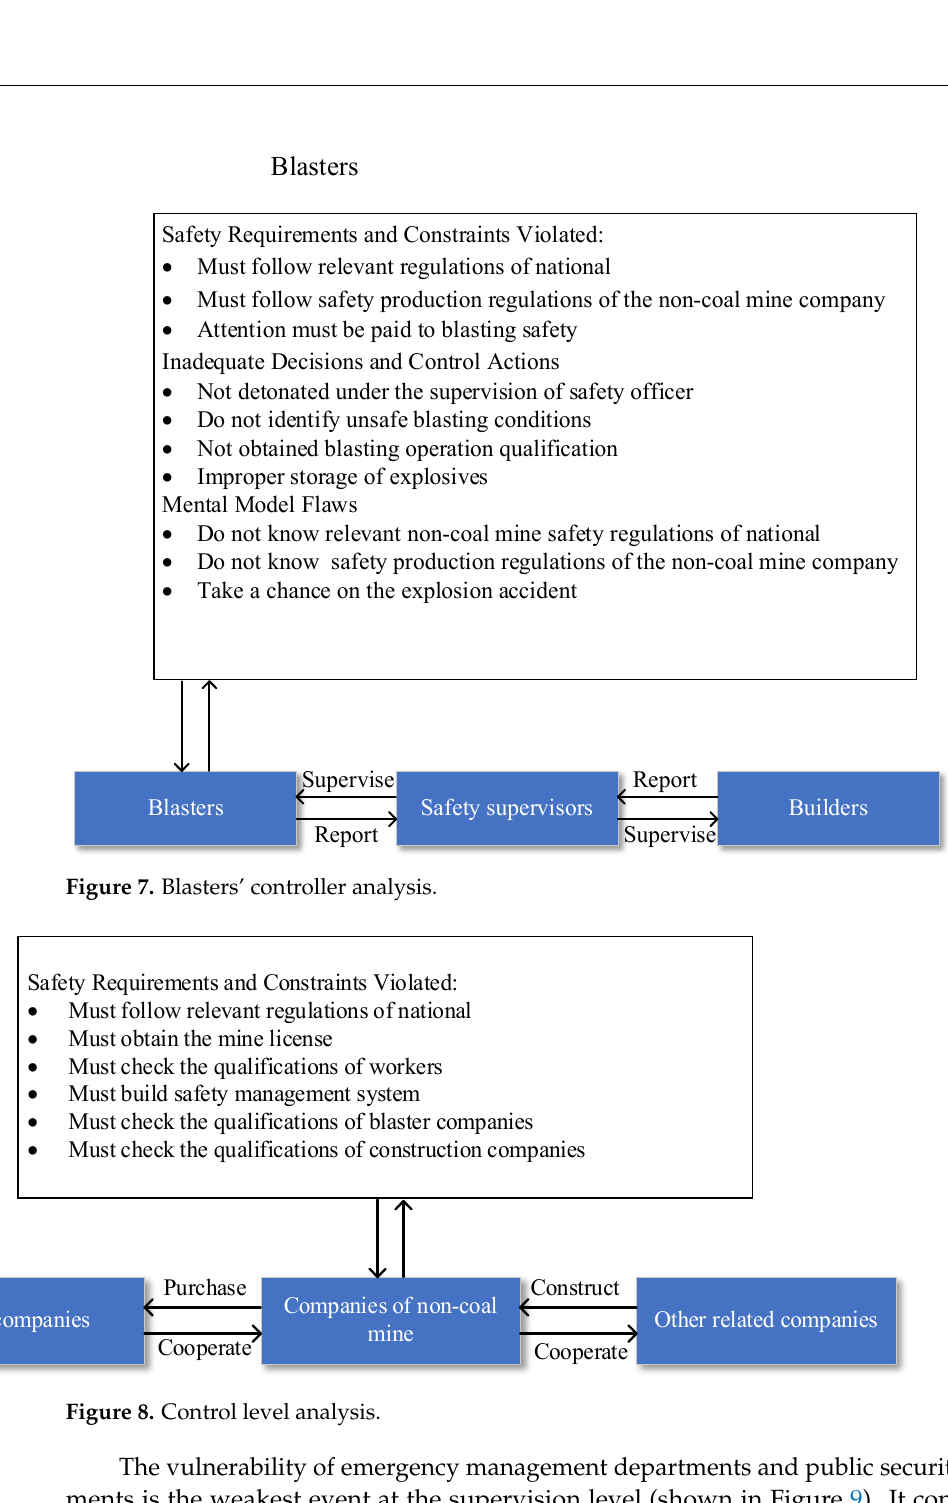
Figure 8. Control level analysis.